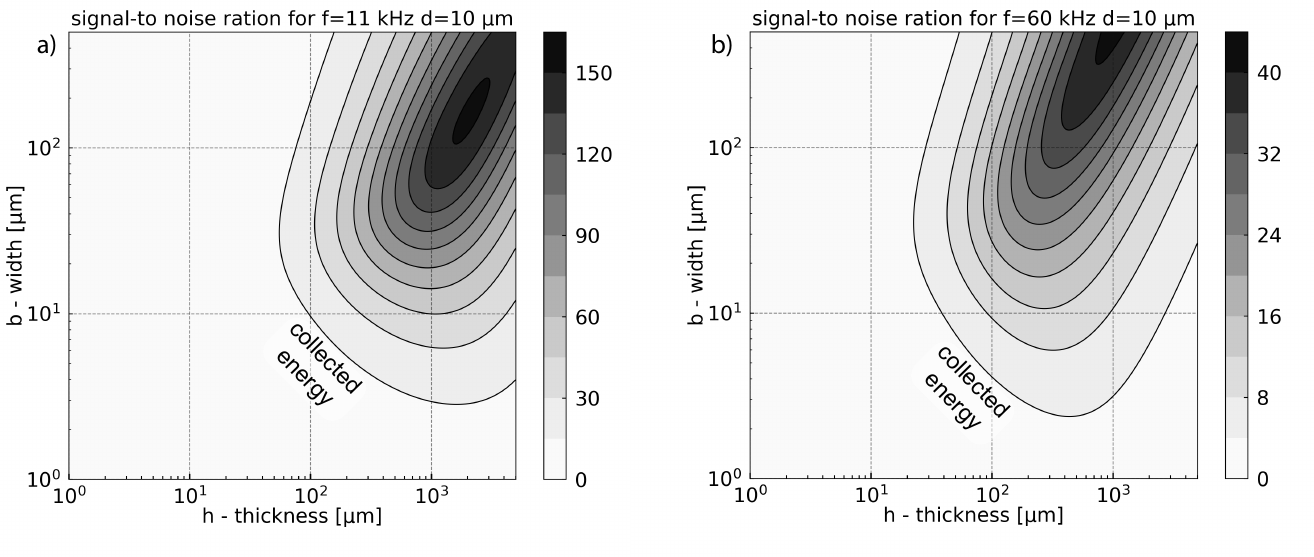
Figure 10. Signal-to noise ratio for a cantilever of fundamental resonance frequency equal to 11 kHz ( a ) and 60 kHz ( b ), a gap between support and cantilever equal to d = 10 µ